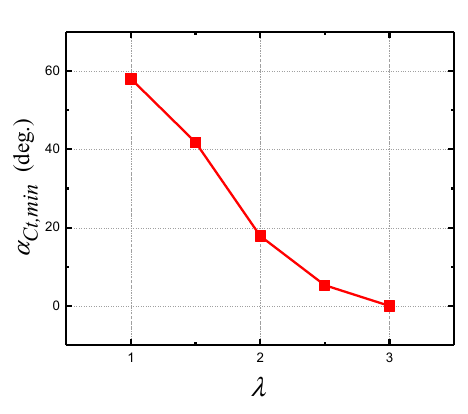
Figure 19. α ct.mix of a blade with λ .